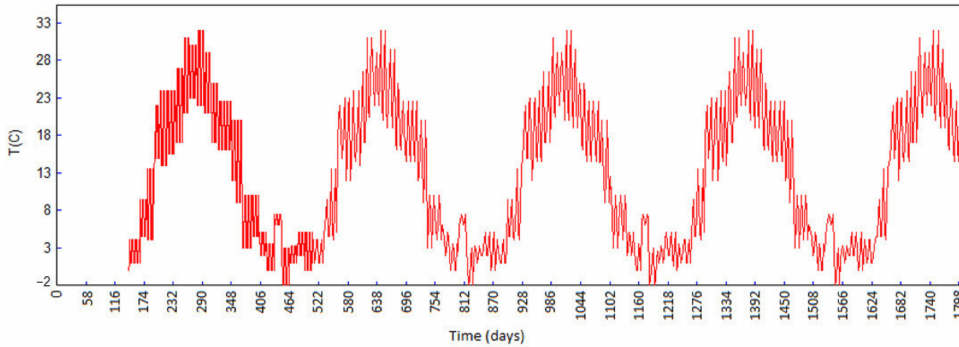
Figure 10. Concrete temperature ( ◦ C) in node 2853 (downstream face).